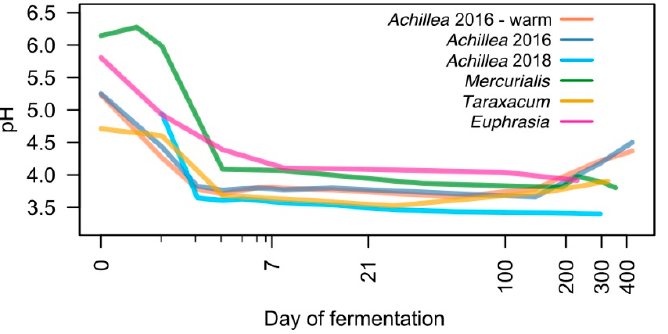
Figure 2. pH values during fermentation of all MPs, according to GHP methods 33c ( Achillea and Euphrasia ) and 34c ( Mercurialis and Taraxacum ). Achillea 2016 was also fermented without cooling during the initial 7 days (“Achillea 2016—warm”). Note the log-scale of the time axis.